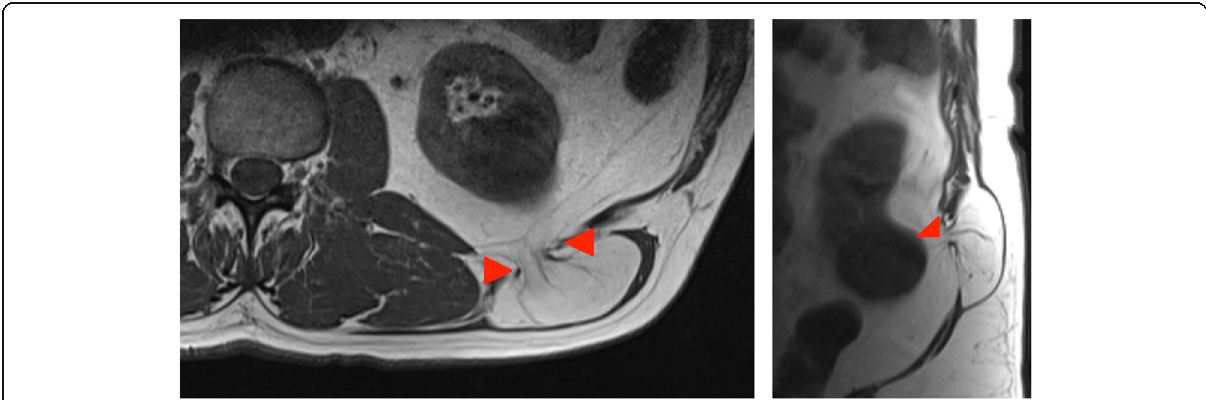
Fig. 9 Left panel: Axial T1-weighted MR image demonstrates a defect in the left abdominal wall at the level of the inferior lumbar triangle, with protrusion of a retroperitoneal tumour with predominant fat signal intensity into the subcutaneous fat (red arrows). Right panel: Sagittal T1- weighted image: red arrowhead points out the hernial defect in the inferior lumbar